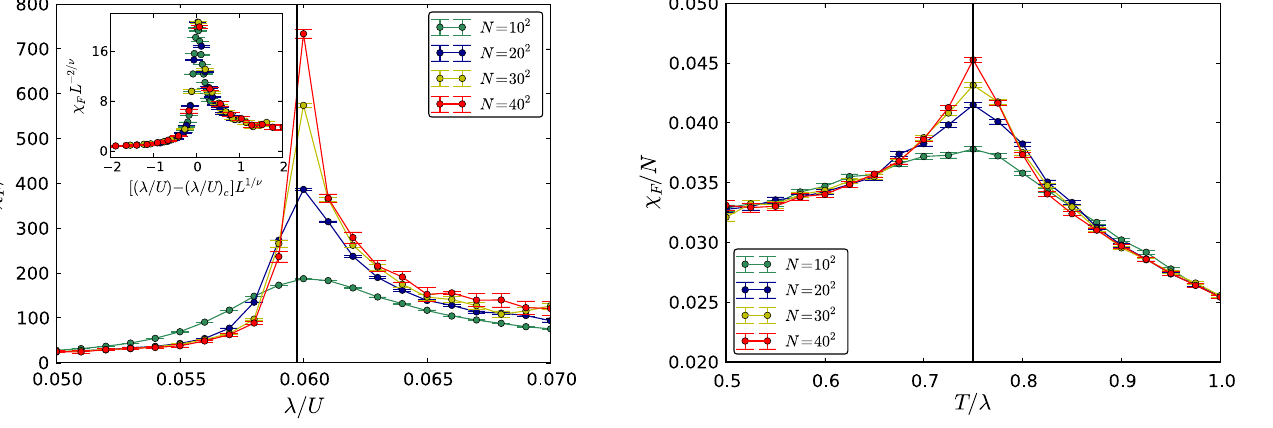
FIG. 5. Fidelity susceptibility per site of a XXZ model on square lattice versus temperature. The vertical line indicates the critical temperature determined in Ref.